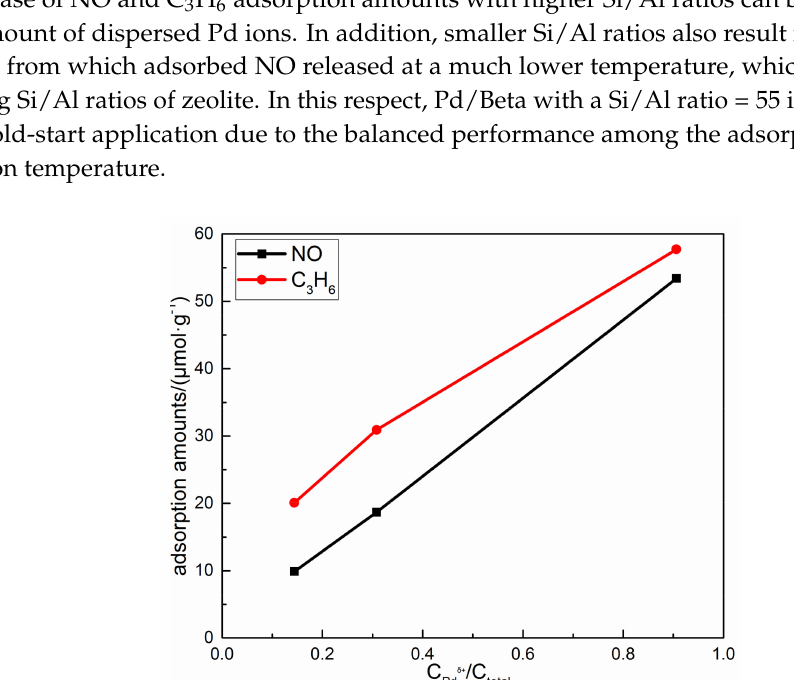
s1, Figure S1: N2 adsorption-desorption isotherm of H-Beta (a) and Pd/Beta (b) samples with different Si/Al ratios. Figure S2: Pore size distribution curves of H-Beta (a) and Pd/Beta (b) samples with different Si/Al ratios. Figure S3: HRTEM figures of each sample (a: Pd/16; b: Pd/55; c: Pd/83). Figure S4: In situ FT-IR of NH3 adsorption (temperature: 80 ◦ C; flow: 500 ppm NH 3 + N 2